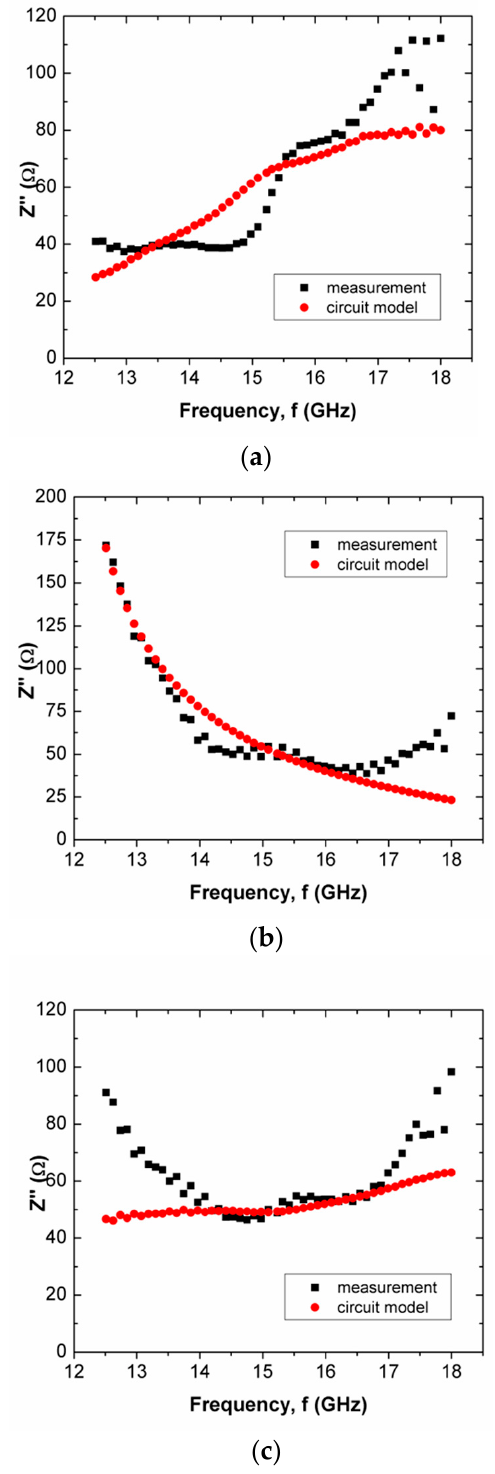
Figure 8. Comparison between measured and simulated Z” of scaffold composites with ( a ) composition A, ( b ) composition B and ( c ) composition C, at Ku-band.